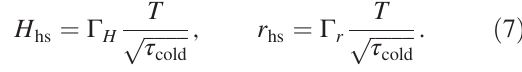
FIG. 1. Hot-spot and turning-point magnetoresistance scal- ing functions and comparison with hyperbola. The MR [ Δ ρ ¼ ρ ð H Þ − ρ ð H ¼ 0 Þ ] in both the turning-point and hot-spot models is controlled by two parameters, r and H (tp and hs tp ; hs tp ; hs indicate turning-point and hot-spot, respectively). The derivations of the parameters in terms of antiferromagnetic gap, spin- susceptibility, and electronic-band parameters are given in the Supplemental Material [34]. The MR from the hot spots or turning points follows scaling functions (black lines), with exact expressions given in the Supplemental Material [34]. The ¼ functions are well approximated by a hyperbola Δ ρ =r ffiffiffiffiffiffiffiffiffiffiffiffiffiffiffiffiffiffiffiffiffiffiffiffiffiffiffiffiffi p tp ; hs 1 þ ð H=H Þ − 1 (red line). tp ; hs